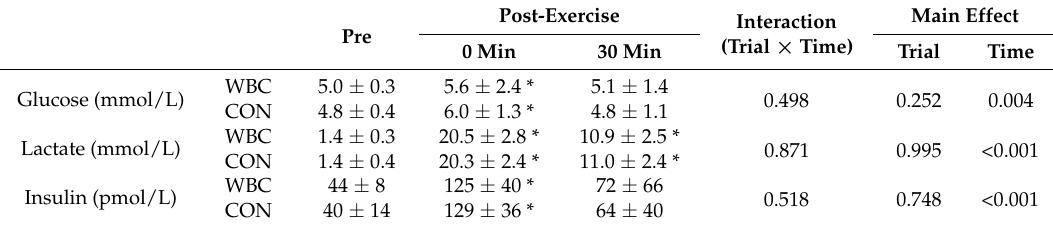
Table 3. Blood glucose, lactate and serum insulin